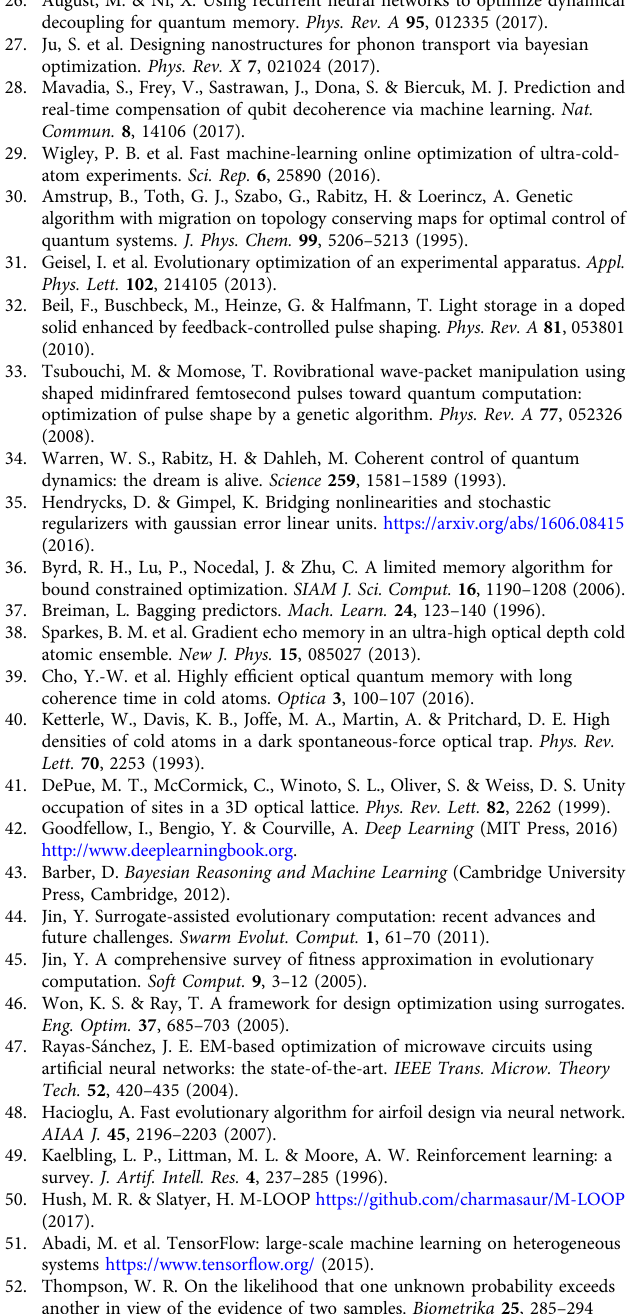
contributes every fourth prediction (not shown on the